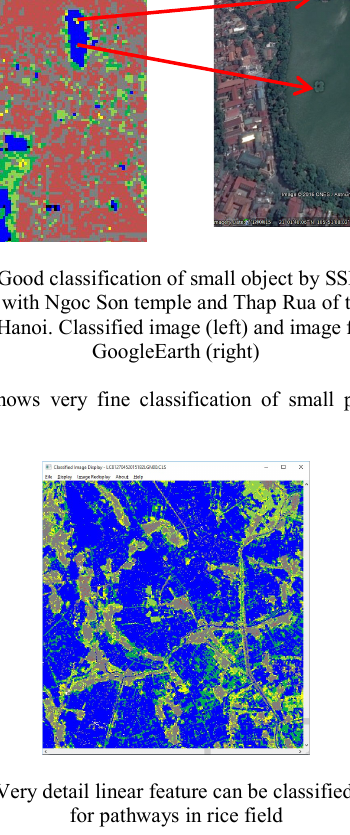
Figure 5. Very detail linear feature can be classified. Example for pathways in rice field Theoretically, surface reflectance of a stable object does not change for a given remote sensor. However, in practice we observe slight changes of surface reflectance of built up in Hanoi when we compare data collected in 2013 and 2015. The changes of surface reflectance causes slight changes in classification results as shown in Figure 6.